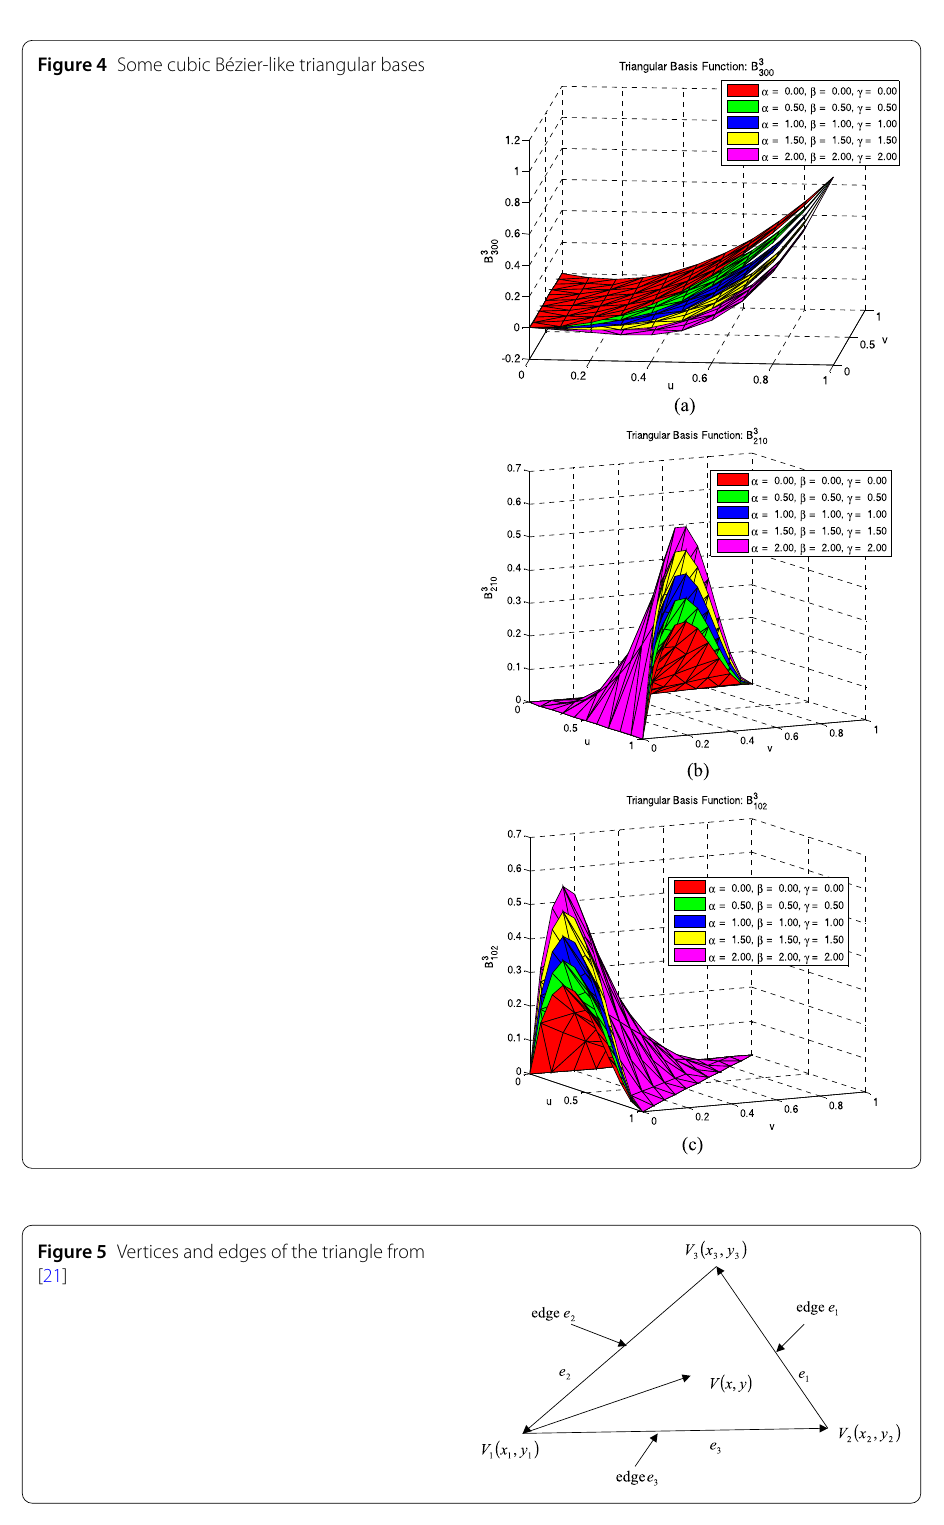
where F ( V 1 ) = b 300 , F x ( V 1 ) and F y ( V 1 ) are given at the vertex V 1 . Similarly, we can obtain that F ( V 2 ) = b 030 , F x ( V 2 ) and F y ( V 2 ) and F ( V 3 ) = b 003 , F x ( V 3 ) and F y ( V 3 ). The partial deriva- tives are estimated by using Goodman et al. [16] method. Then, by simple derivation,